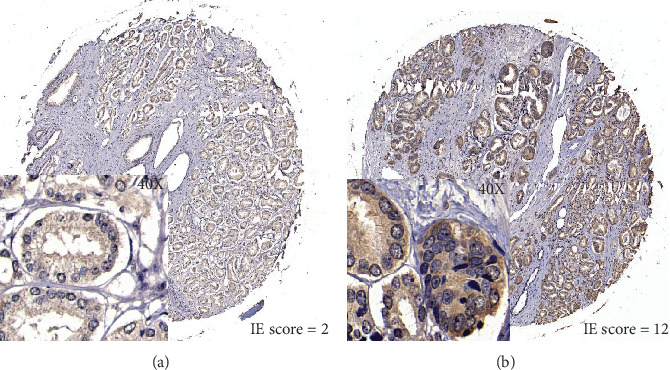
FASN expression pattern was analyzed by the IE score in prostate cancer tissues (40 times zoom in square).